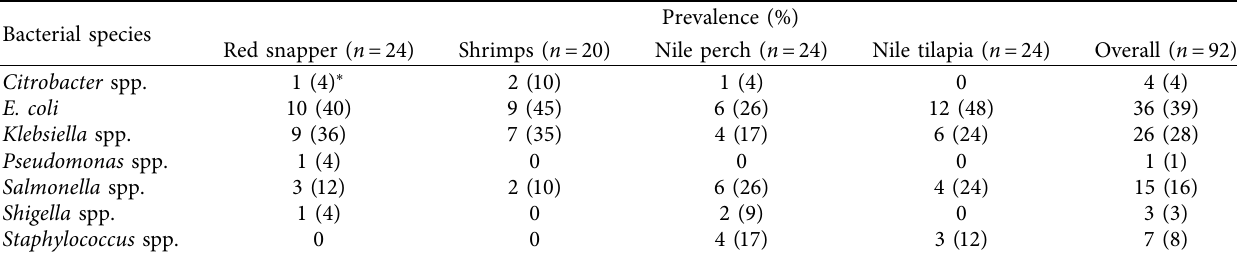
Table 2: Occurrence of different bacteria on retail fish from Dar es Salaam. Bacterial species